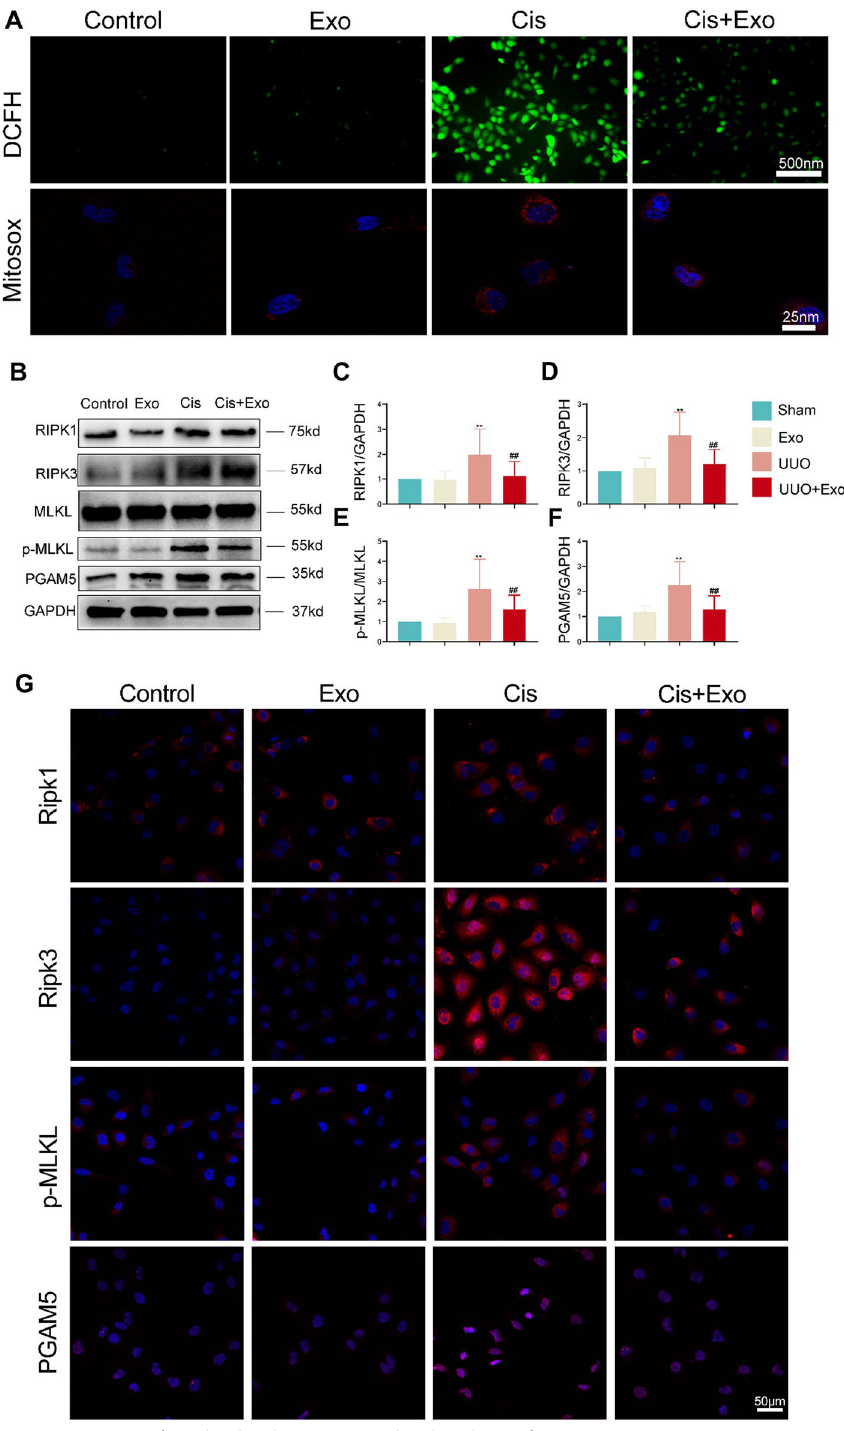
Fig. 5 Examination of ROS level and necroptosis-related markers in four groups in vitro. A Immunofluorescence detected with the ROS indicator DCFH (green) and the mitochondrial ROS (mtROS) indicator MitoSox (red) in each group. B Western blot of necroptosis-related markers (RIPK1, RIPK3, MLKL, p-MLKL, and PGAM5) in each group. C – F Relative expression of necroptosis-related markers detected by western blot. * p < 0.05, ** p < 0.01, compared with control group; # p < 0.05, ## p < 0.01, compared with cisplatin (Cis) group. G Immunohistochemistry of necroptosis-related markers in each